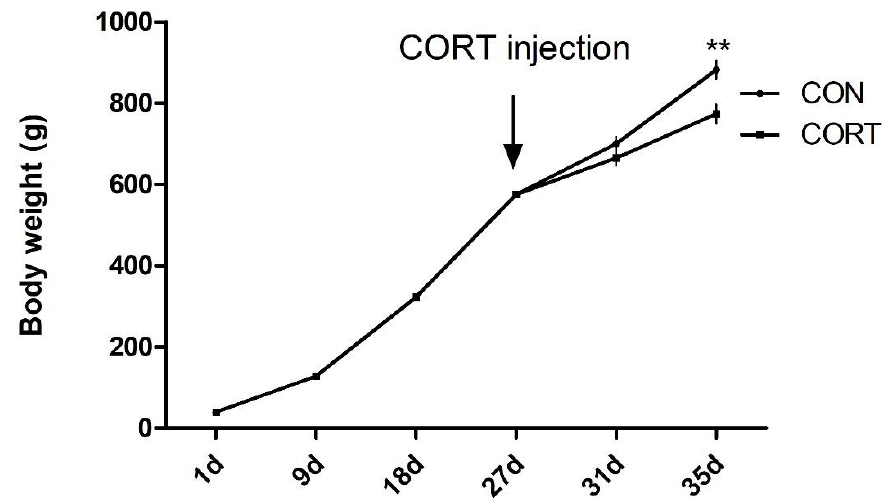
Figure 1. Changes in body weight. Data are presented as means ± SEM (n = 16); ** p < 0.01. CON, control group; CORT, corticosterone-treated group.